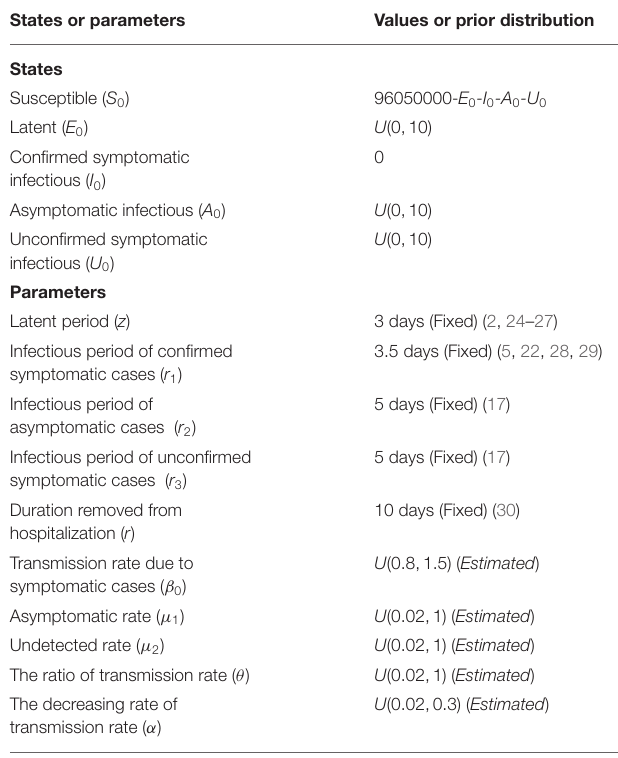
TABLE 1 | Initial states and parameter’s setting in the model of the main